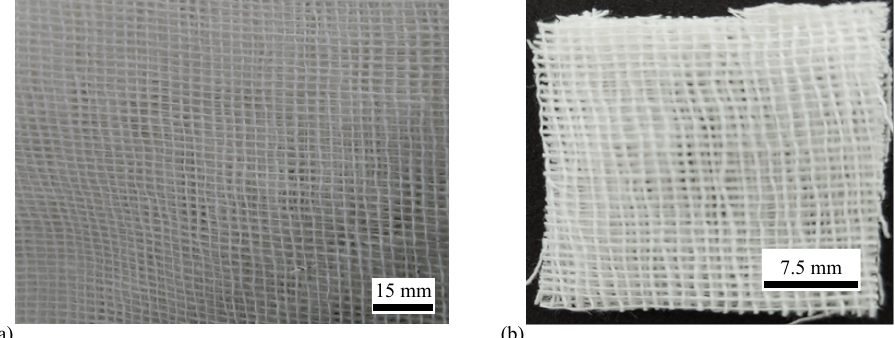
Figure 1. ( a ) Sterile compression of cotton microfibers. ( b ) Sterile compression pack of cotton